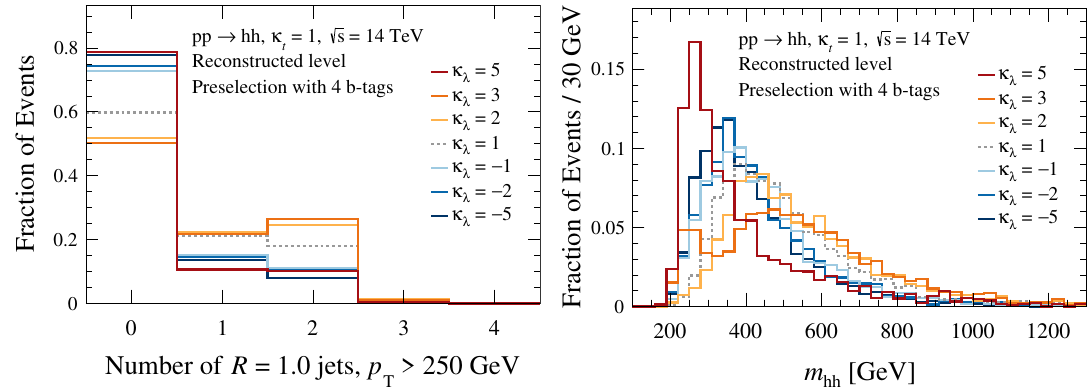
Figure 5. Unit normalised distributions of pp → hh signals with different κ λ (solid lines) compared with the SM (grey dashed) at reconstructed level. The preselection with four b -tagged jets is applied. Displayed are (left) the number of reconstructed large jets and (right) the m hh variable. Negative (positive) values of κ λ are coloured by shades of blue (orange). Large jets have a radius parameter of R = 1 . 0 and p T > 250